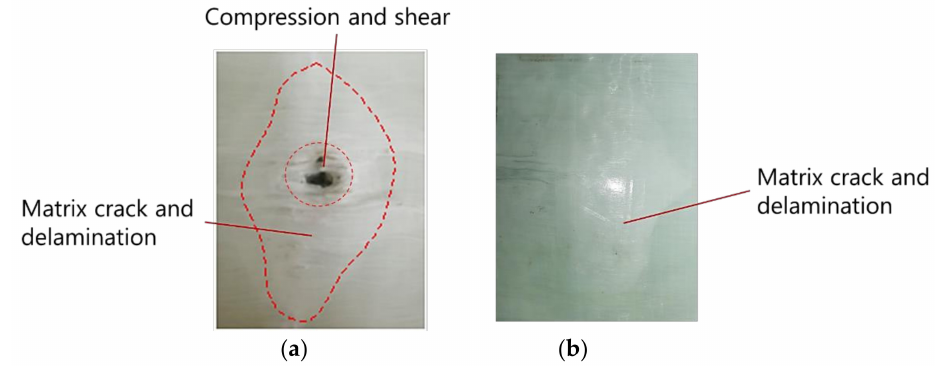
Figure 7. Visible damage morphologies of the ( a ) front surface and ( b ) rear surface after the projectile